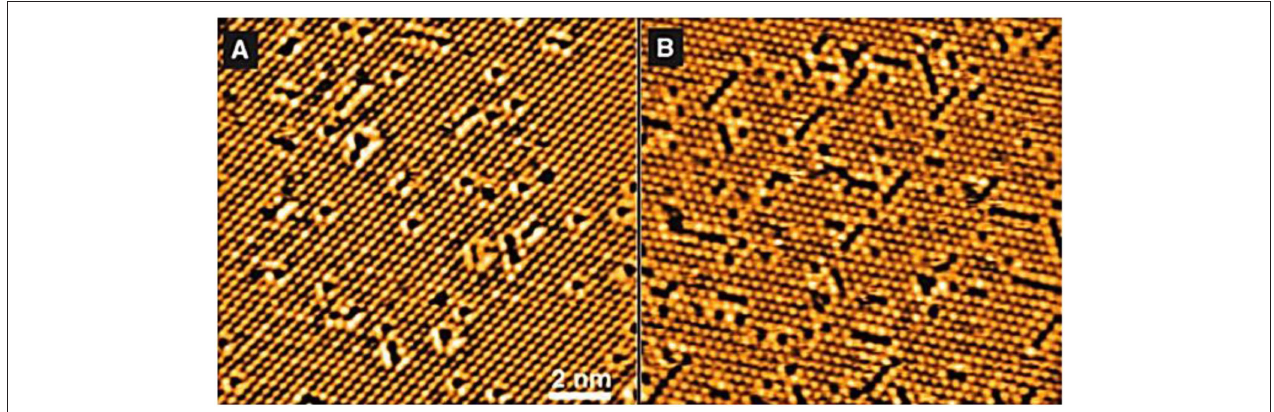
FIGURE 6 | (A) Schematic of the surface topography of a generic reducible oxide with its their respective adatomos and vacancies. (B,C) Microscopies (STM) separated by 1min showing the recombination between adenomas and vacancies (adapted from Bryant et al., 2011).